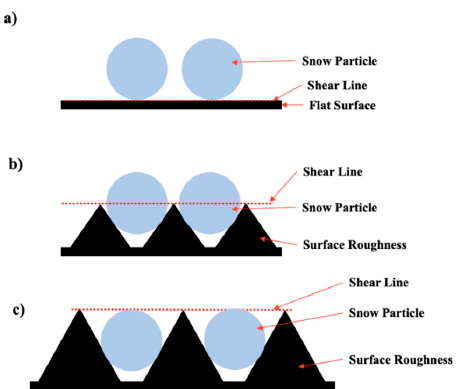
Figure 5. Impact of surface roughness on the snow adhesion mechanism, hypothesized schematically. ( a ) On a very flat surface, snow does not become trapped within the roughness and shears at the interface. ( b ) When the size of snow particles and surface roughness are on the same range, the snow particle are sheared in half, leading to enhanced adhesion strength values. ( c ) When the snow particles are smaller than the surface roughness, shear adhesion strength is lower because some snow particles glide over others that are inside the